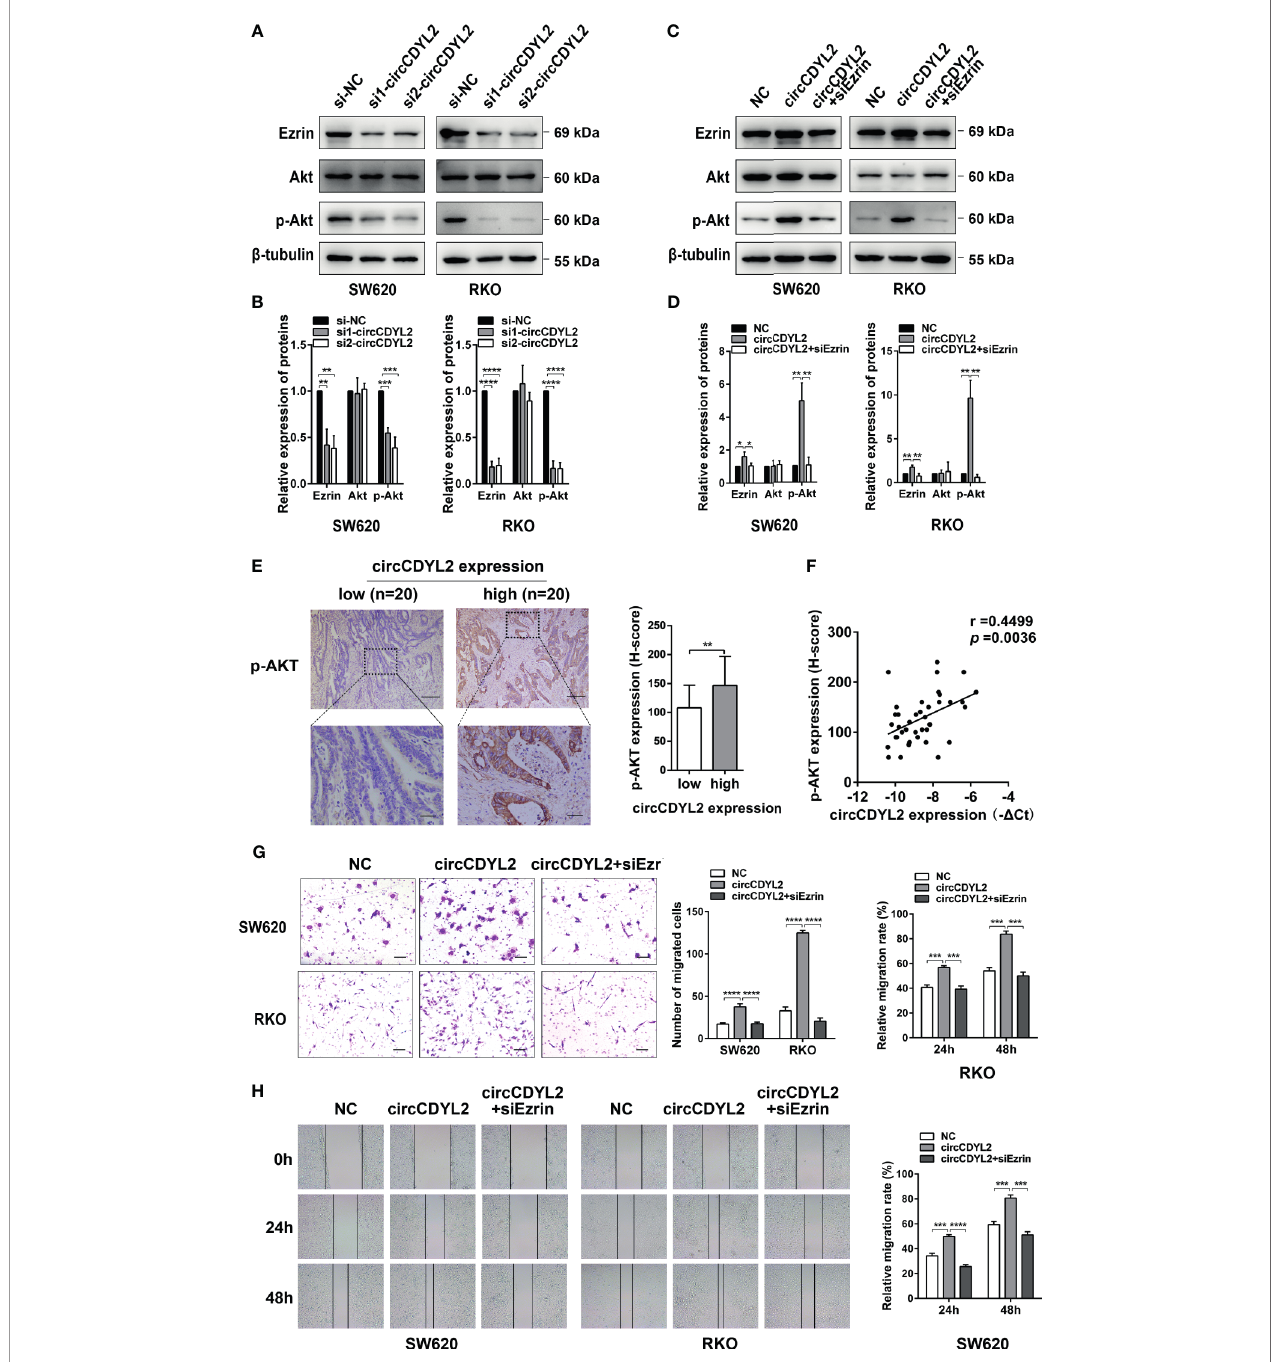
FIGURE 6 | CircCDYL2 promoted AKT phosphorylation by upregulating Ezrin protein levels. (A) Western blotting revealed that silencing circCDYL2 expression resulted in decreases in Ezrin protein levels and Akt phosphorylation. (B) Quantitative graphs for 6A. (C) Western blotting showed that overexpression of circCDYL2 caused increased Ezrin protein expression and AKT phosphorylation. These effects could be abolished by co-transfection with Ezrin siRNA. (D) Quantitative graphs for 6C. (E) IHC showed that p-AKT levels in CRC tissues were higher in the high circCDYL2 group ( n = 20) than in the low circCDYL2 group ( n = 20). Scale bars: Top, 100 m m; bottom, 20 m m. (F) The correlation analysis demonstrated a positive correlation between circCDYL2 expression and p-AKT levels. n = 40. (G) Transwell and (H) wound healing assays showed that enhanced CRC cell migration caused by circCDYL2 overexpression could be abolished by Ezrin knockdown. * p < 0.05, ** p < 0.01, *** p < 0.001, **** p <